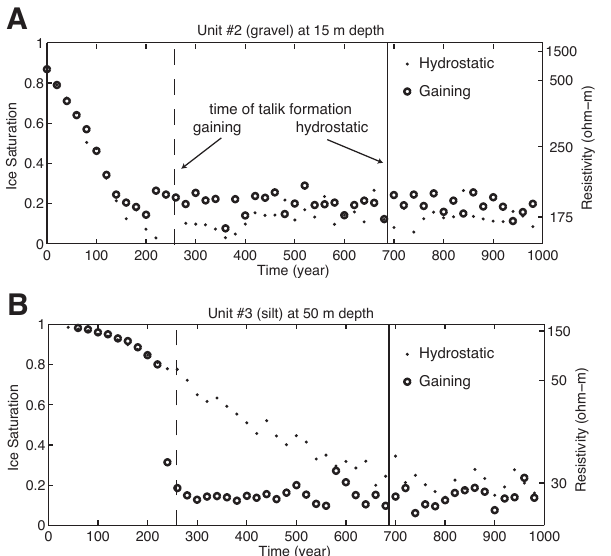
Figure 9. Change in ice saturation and resistivity as a function of time. Results are shown for the 6m deep lake hydrostatic and gain- ing lake scenarios within (a) the gravel layer, unit #2, at a depth of 15m and (b) the silt layer, unit 3, at a depth of 50m.